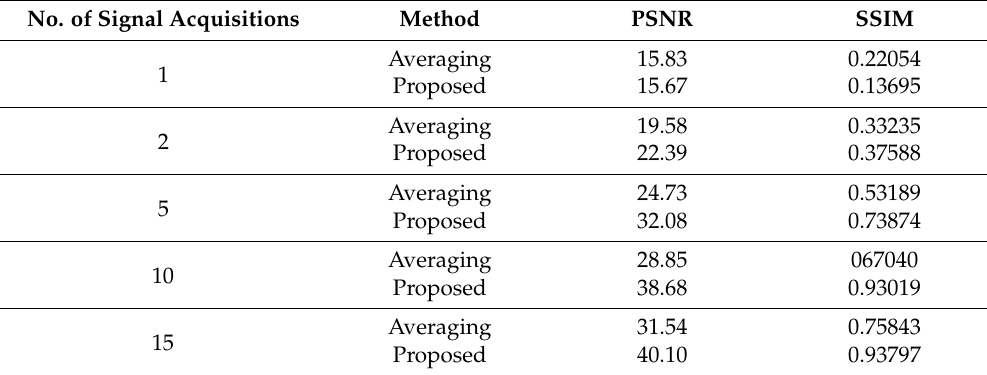
Figure 6. Performance comparison between normalized least mean square (NLMS), block normalized least mean square (BNLMS) filtering, and proposed methods in terms of signal amplitude enhancement and computational complexity. Table 1. Comparison between averaging and the proposed method for different numbers of acquisitions.